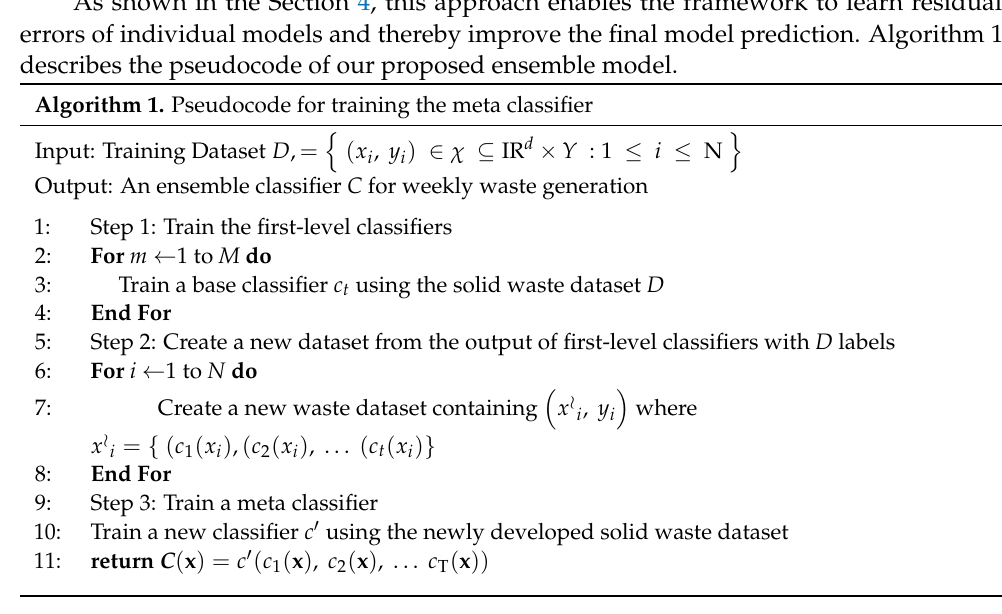
Figure 1. The proposed method for the prediction of solid waste generation (in model optimization phase: M = model, P = prediction).